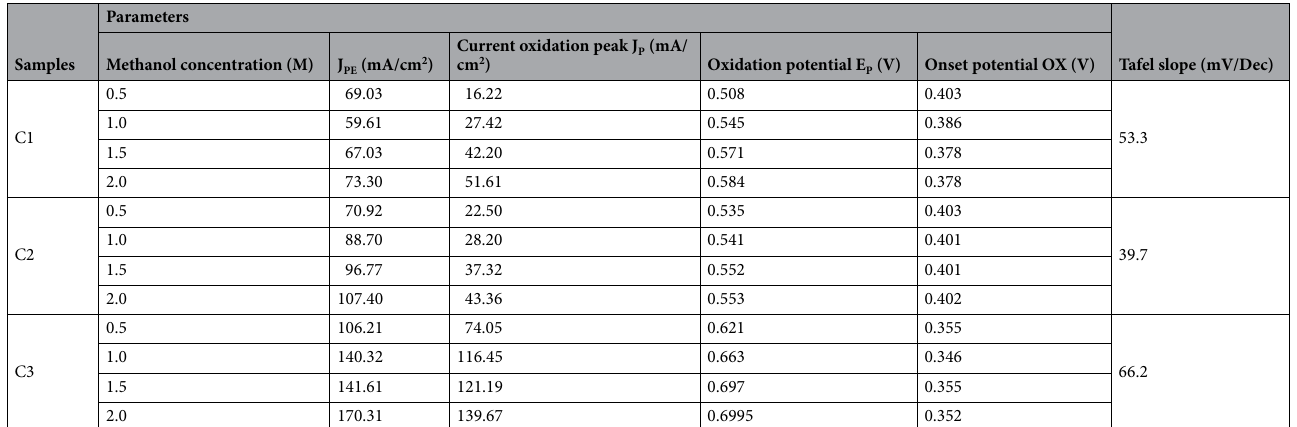
Table 3. Summary of the electrochemical parameters of the three catalysts. J PE is the current density values of the extension peak at potential 0.8